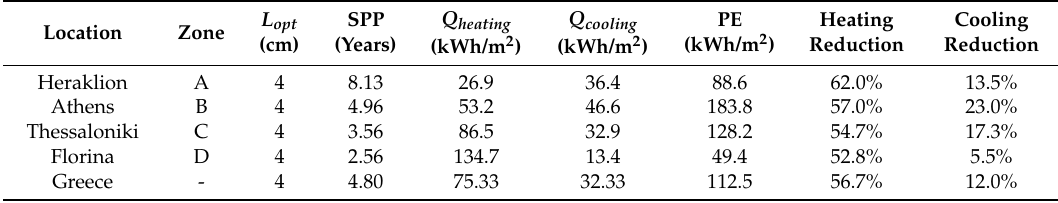
Table 6. Final results for the optimum insulation thickness. PE—primary energy consumption.